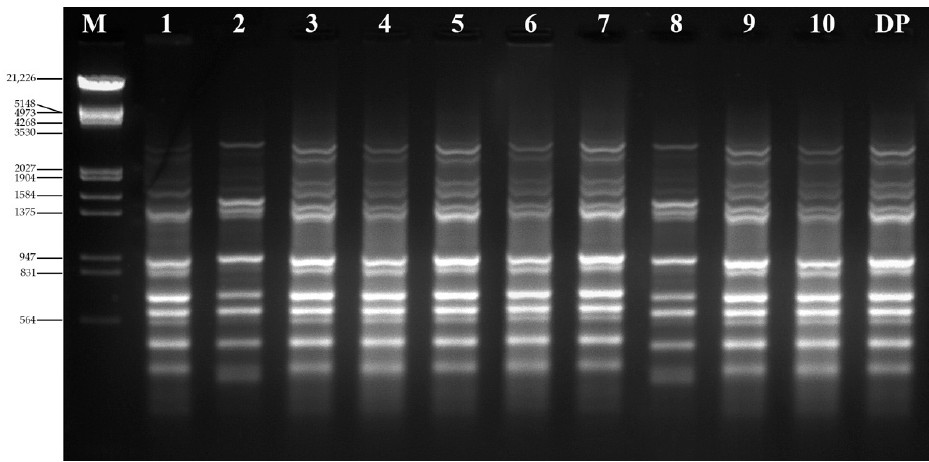
Figure 4. Representative ISSR profiles of Ruta chalepensis using primer UBC-827. Lane